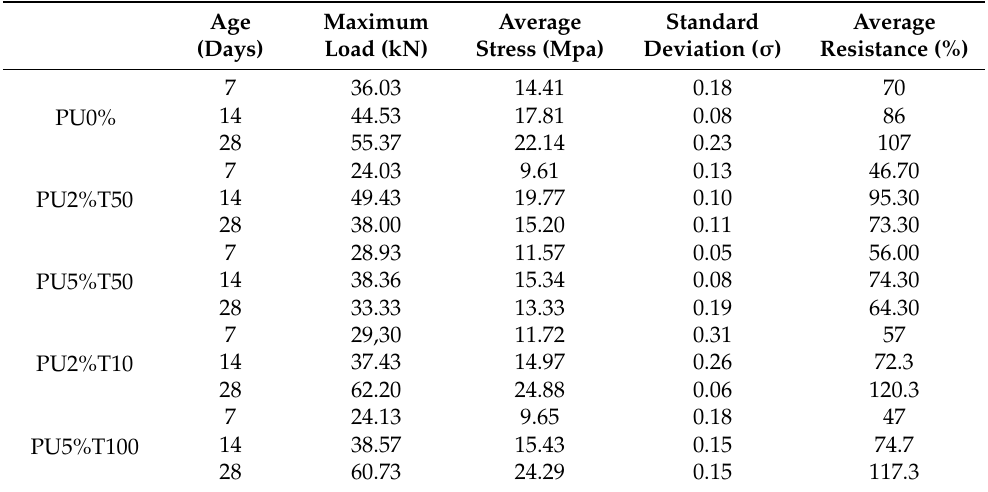
Table 6. Resistance test for control sample (PU0%) and resistance of mortars with polyurea retained in sieves 50 and